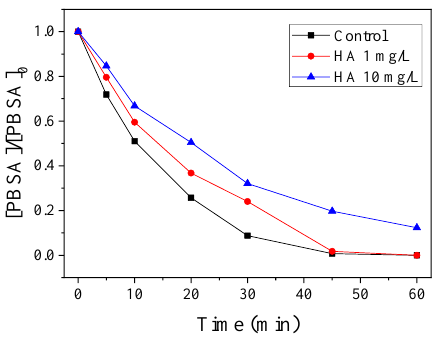
Figure 5. Influence of humic acid (HA) on PBSA removal. Condition: [PBSA] = 5 mg L −1 ; [catalyst] = 50 mg L −1 ; [PMS] = 250 mg L −1 ; T = 25 °C; and without pH adjustment.